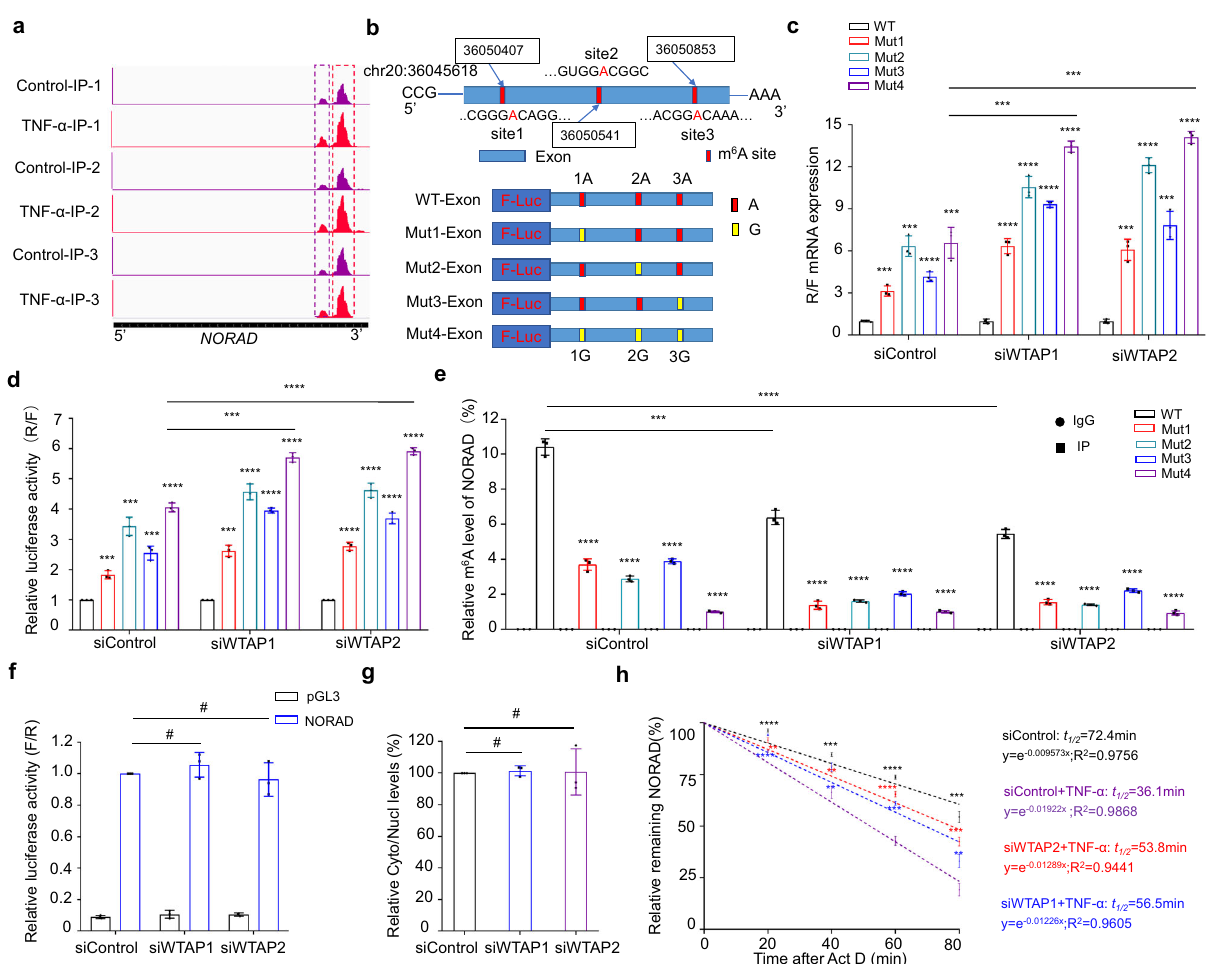
Fig. 5 NORAD stability is regulated by m 6 A modi fi cation. a , b PEAK of NORAD transcript by Me-RIP-Seq; m 6 A sites in NORAD and the corresponding mutant sites. c mRNA expression of wild-type or site-mutant NPCs with or without WTAP silencing ( P = 0.0005; 0.0004). Data are shown as the mean ± SD, n = 3. *** P < 0.001, **** P < 0.0001, two-tailed unpaired Student ’ s t test. d Dual-luciferase reporter assay of wild-type or site-mutant NPCs with or without WTAP silencing ( P = 0.0002; P < 0.0001). Data are shown as the mean ± SD from three independent experiments. *** P < 0.001, **** P < 0.0001, two-tailed unpaired Student ’ s t test. e Me-RIP-PCR analysis of the m 6 A level of NORAD wild-type or site-mutant NPCs with or without WTAP silencing ( P = 0.0003; P < 0.0001). Data are shown as the mean ± SD from three independent experiments. *** P < 0.001,**** P < 0.0001, two-tailed unpaired Student ’ s t test. f Dual-luciferase reporter assay of the activity of the NORAD promoter in NPCs with or without WTAP silencing. Data are shown as the mean ± SD from three independent experiments. # NS, two-tailed unpaired Student ’ s t test, compared between siWTAP and siControl groups. g Analysis of NORAD expression in nuclear and cytoplasmic fractions by RT-qPCR. Data are shown as the mean ± SD from three independent experiments. # NS, two- tailed unpaired Student ’ s t test. h Transcript stability assay of NORAD in senescent NPCs with or without WTAP knockdown at time of 20 ( P < 0.0001; P < 0.0001; P = 0.0018), 40 ( P = 0.0003; P = 0.0041; P = 0.0046), 60 ( P < 0.0001; P = 0.0001; P < 0.0001), 80 min ( P = 0.0001; P = 0.0054; P = 0.0003). Data are shown as the mean ± SD, n = 3. ** P < 0.01, *** P < 0.001, **** P < 0.001, two-tailed unpaired Student ’ s t test. NPCs and found that E2F3, a target of PUM1/2, was also among element (PRE), and two PRE sites are present in the 3 ’ UTR of E2F3 the most signi fi cantly downregulated genes after treatment with (supplementary Fig. 6d). Dual-luciferase reporter plasmids con- TNF- α , which was further con fi rmed by western blot and RT-qPCR taining the E2F3 3 ’ UTR carrying the wild-type PRE or a mutant analysis (Fig. 8a, b). Furthermore, fl uorescence immunostaining of PRE in which the 5-UGUACAUA-3 motif (wtPRE) had been E2F3 con fi rmed the decreased expression of E2F3 in degenerated mutated to 5-ACAACATA-3 (mutPRE) were transfected into NP tissues (Fig. 8c). To assess whether E2F3 is regulated by PUM1/ NPCs with PUM1/2 overexpression plasmids. The luciferase 2 at the posttranscriptional level, RIP-qPCR was performed to activities in NPCs expressing mutated PREs were signi fi cantly determine the binding status of PUM1/2 with E2F3 transcripts higher than those in wild-type NPCs, and the overexpression of (Fig. 8d). Knockdown of E2F3 in NPCs inhibited cell proliferation PUM1 or PUM2 had little in fl uence on mutPRE-containing E2F3, and promoted cellular senescence, while overexpression of E2F3 further con fi rming the binding region and binding sites of PUM1/2 partially blocked the pro-senescence effect of TNF- α in NPCs (Fig. 8g). Furthermore, mRNA stability assays revealed that over- (Fig. 8e, f). The surgically induced IVDD model using AVV con- expression of PUM1 or PUM2 in NPCs decreased the half-life of taining shE2F3 and OE-E2F3 con fi rmed these results in vivo E2F3 transcripts (Fig. 8h), a fi nding which was validated by the (supplementary Fig. 6a – c). The interaction of Pumilio proteins with increased interaction between PUM1 or PUM2 and CNOT1 shown mRNAs depends on the presence of a canonical UGUARAUA by co-immunoprecipitation, immuno fl uorescence, and proximity sequence in the mRNA 3 ’ UTR named the Pumilio response ligation assays (Fig. 8i, j and Supplementary Fig. 6e). In addition, NATURE COMMUNICATIONS| (2022) 13:1469